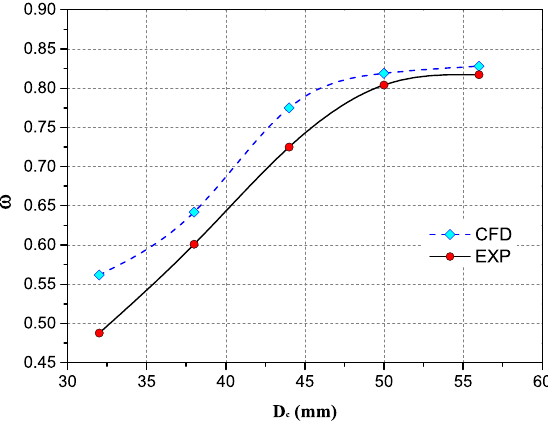
Figure 10. Comparison of predicted results and experimental data for ω with different D c .